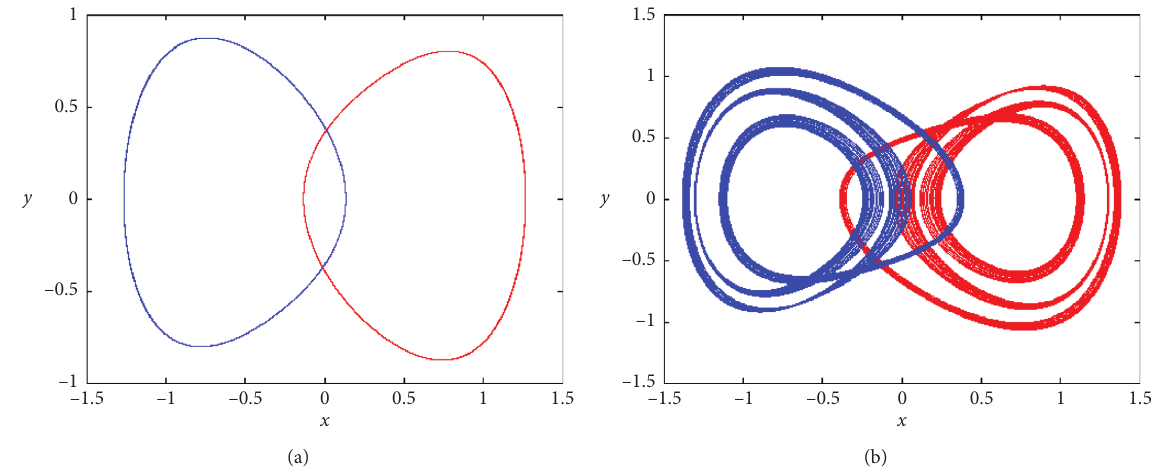
Figure 10: Coexistence of four attractors at the point k � 2.66 of Figure 9(a), for different values of the initial conditions ( x (0), y (0), z (0)): (a) a period-1 attractor and its symmetry for ( ± 0.12, 0, 0); (b) a chaotic spiral attractor and its symmetry for ( ± 0.39, 0, 0).